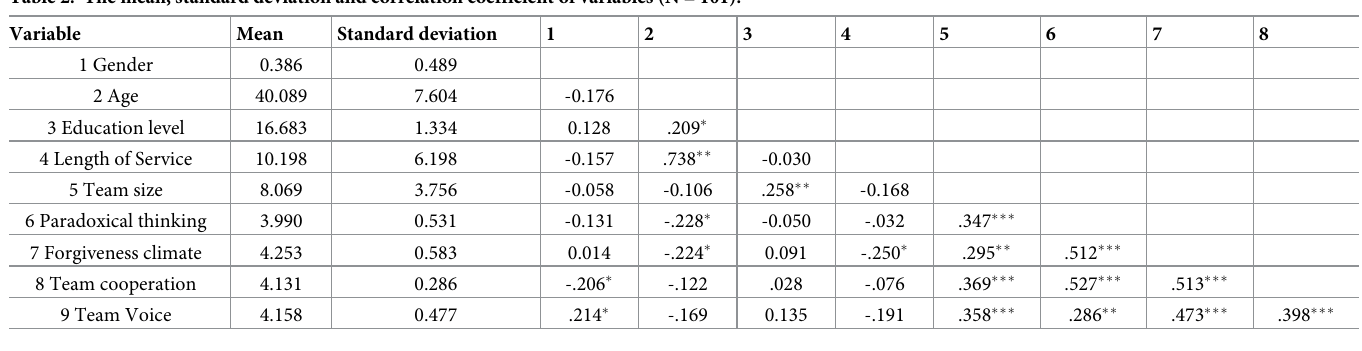
Table 2. The mean, standard deviation and correlation coefficient of variables (N = 101).